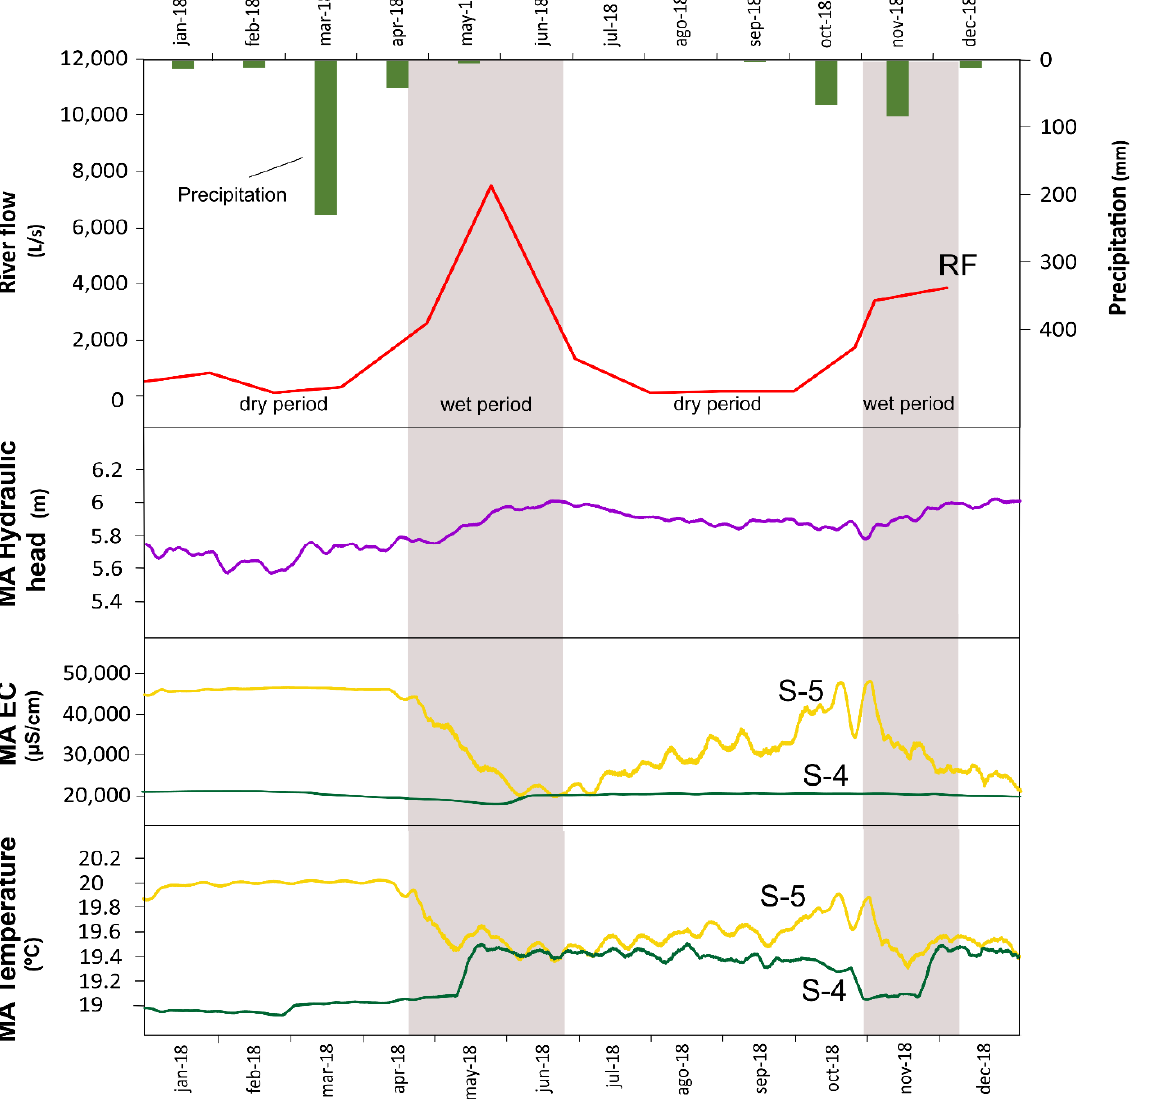
Figure 6. Data during 2018: Monthly measurements of river water flow (red line) and moving average ( MA ) of hourly measurements of H obtained from S-4 and S-5 in purple (same values for both sensors), and EC and T obtained from S-4 (green lines) and S-5 (yellow lines). Wet periods are delimited by the grey areas coinciding with the increment of river flow.